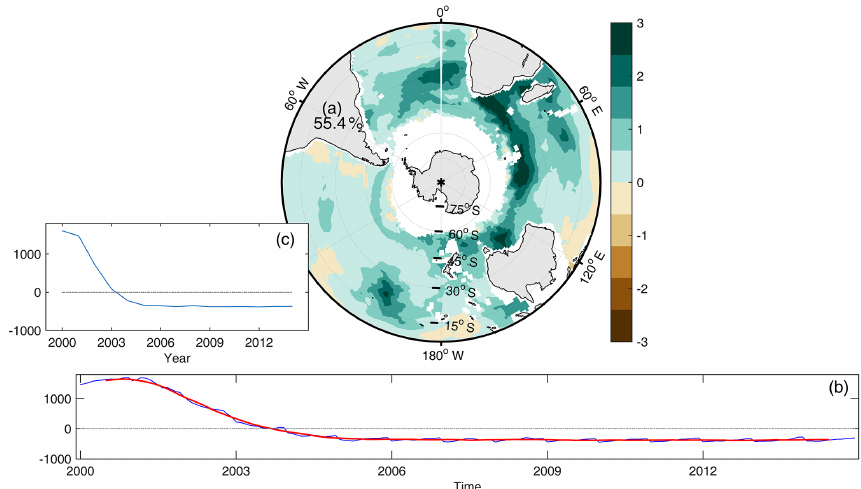
Figure 8. (a) Pattern and (b) time series (blue: monthly; red: 13-month smoothed) of EOF1 of salinity on 27.36 γ n surface. (c) Yearly mean time series of EOF1. Calculated from SODA